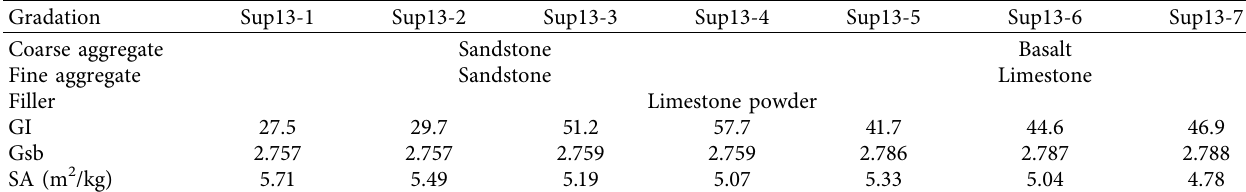
Table 2: Values of variables required for modeling (I).